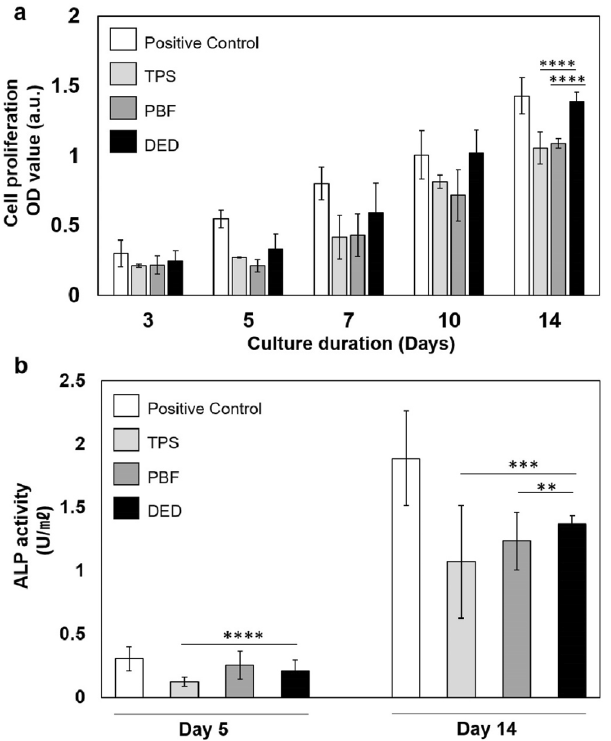
Figure 3. Cell proliferation and ALP activity of Saos-2 on different porous structures. Saos-2 cells were seeded at a density of 2.4 × 10 4 cells/well and cultured for 14 days. ( a ) Cell proliferation was measured using CCK-8. ( b ) The enzyme activity of ALP within cells was measured on days 5 and 14. The trend of ALP activity was similar to that of cell proliferation (mean ±